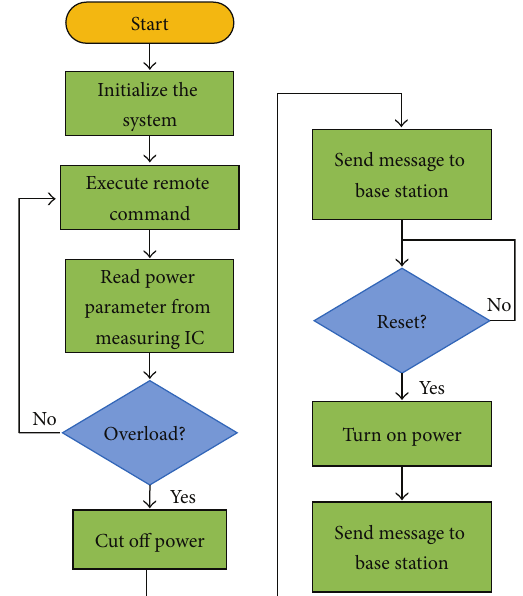
Figure 7: Flow chart of the sensor node.